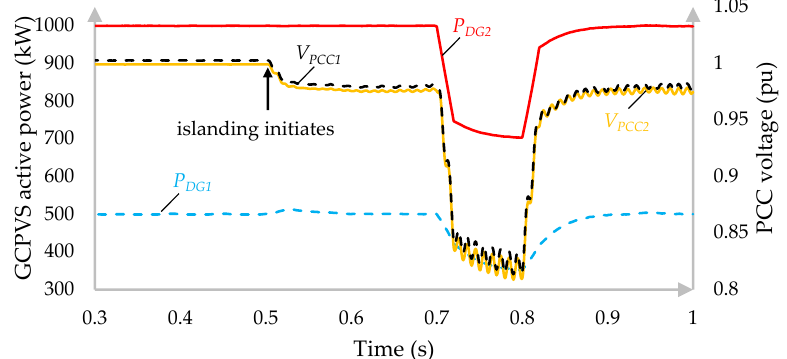
Figure 8. Multi-DGs islanding outputs for the distinct bus connection scenario.